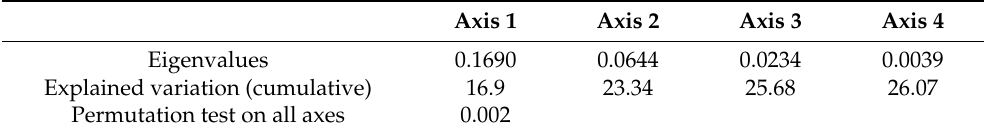
Table 6. Eigenvalues and Explained Variance of the RDA Axes for Various